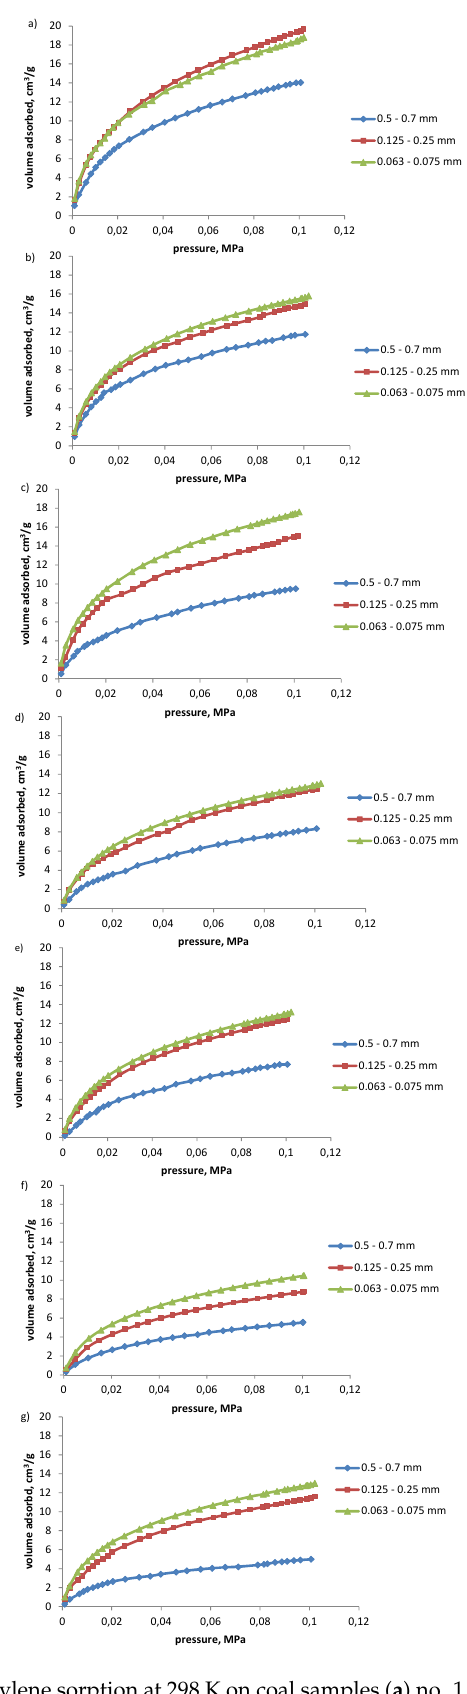
Figure 2. Isotherms of acetylene sorption at 298 K on coal samples ( a ) no. 1, ( b ) no. 2, ( c ) no. 3, ( d ) no. 4, ( e ) no. 5, ( f ) no. 6, ( g ) and no. 7.